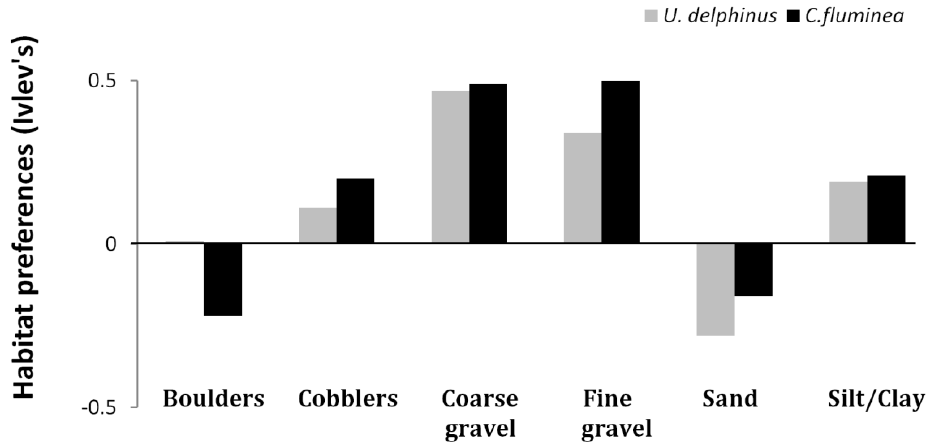
Figure 4. Habitat preferences of U. delphinus and C. fluminea according to Ivlev’s electivity index. E i is scaled so that E i < 0 indicates avoidance and E i > 0 indicates preference. Table 4. Results from the post hoc z test after the G likelihood ratio was performed comparing size structure for both bivalve species. Same letters from a, b and c denote a subset of Year categories whose column proportions do not differ significantly from each other at the 0.05 level